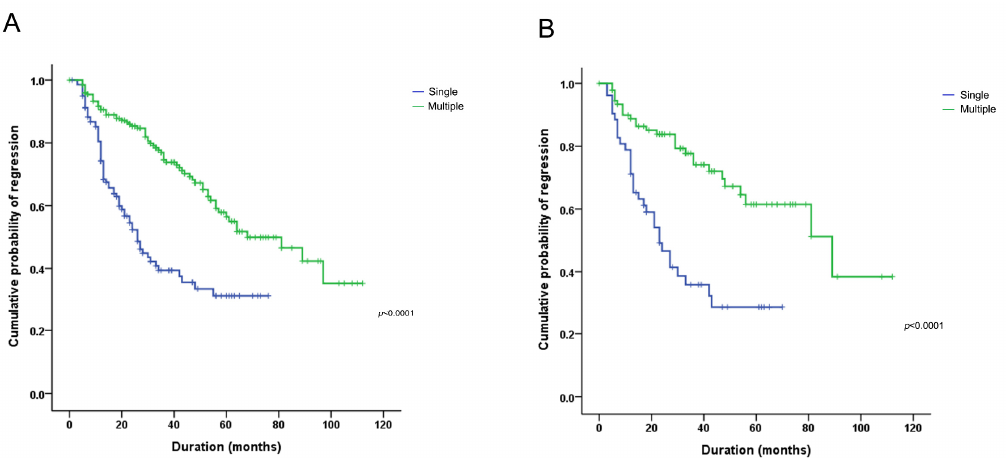
Figure 4. Kaplan–Meier curve of HPV infection during the follow-up period (in single and multiple HPV infections) ( A ) in all cases and ( B ) among those who had HSIL and SQCC. Regression was defined as the absence of HPV detection during any follow-up